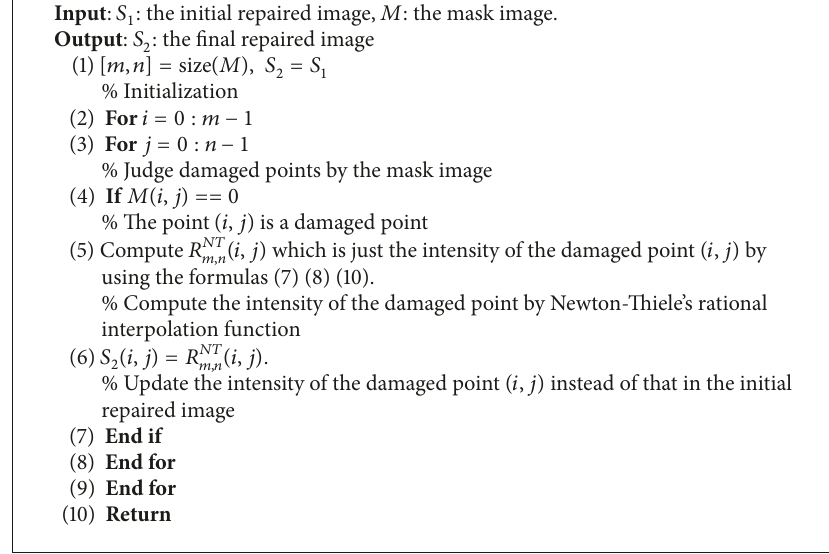
Algorithm 2: Refining inpainting via Newton-Thiele’s rational